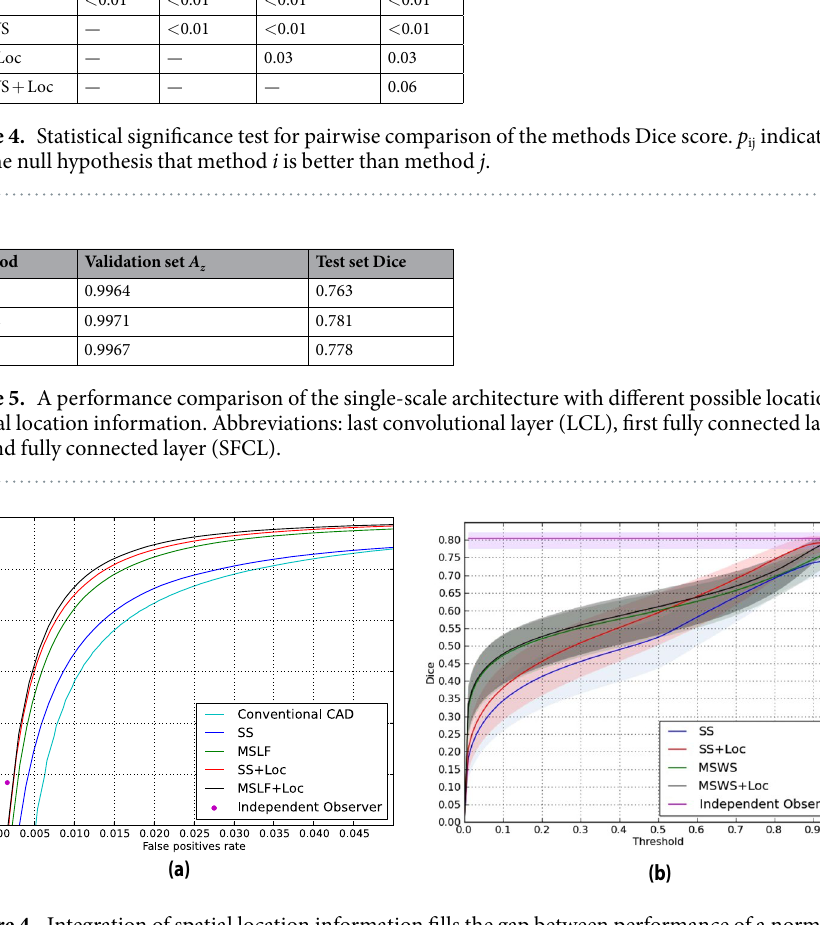
Figure 4. Integration of spatial location information fills the gap between performance of a normal CNN and human observer. ( a ) An ROC comparison of different CNN methods, a conventional segmentation method and independent human observer, considering observer 1 as the reference standard. ( b ) A comparison of different methods on Dice score as a function of binary masking threshold. The light shades around the curves indicate 95% confidence intervals with bootstrapping on patients.